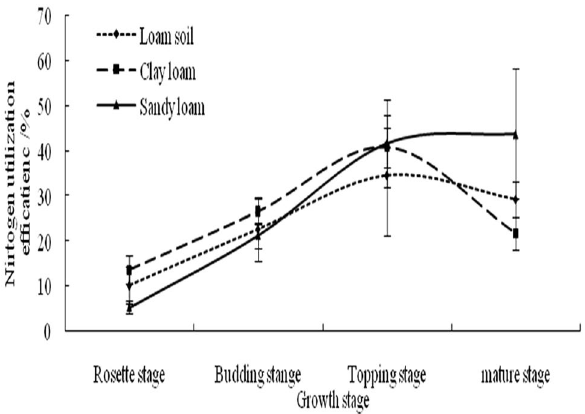
Figure 2. N use efficiency of flue-cured tobacco in different texture